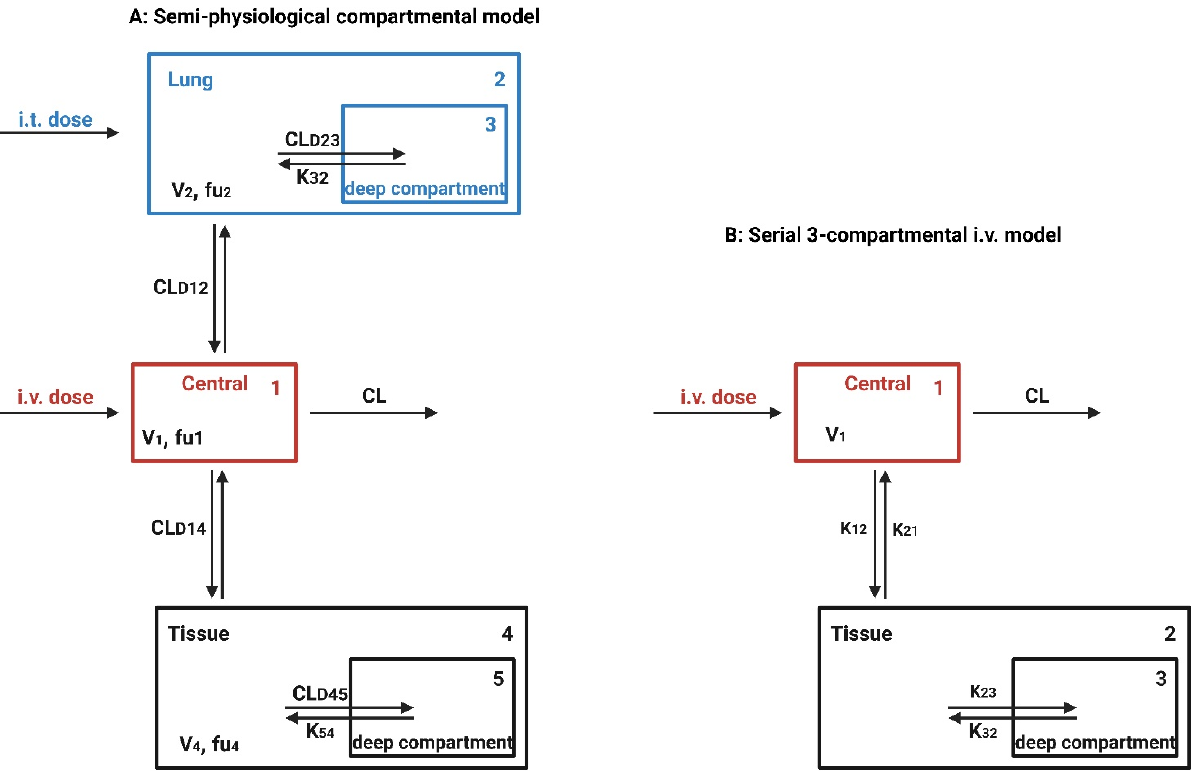
Figure 16. Schematic representation: ( A ) Structure of the compartmental model. ( B ) Serial three- compartmental model. Table 5. Summary of in vivo whole animal-based models for testing inhaled aerosolized mist/dried lipid bilayer vesicles.